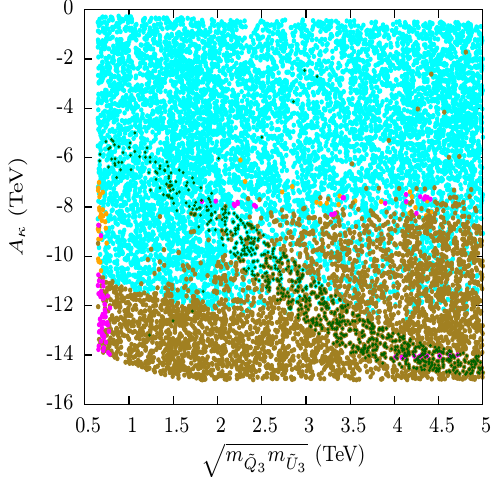
p m m - A (cid:20) plane. The (cid:12)xed parameters are also as e Q 3 e U 3 = m . e Q 3 e U 3